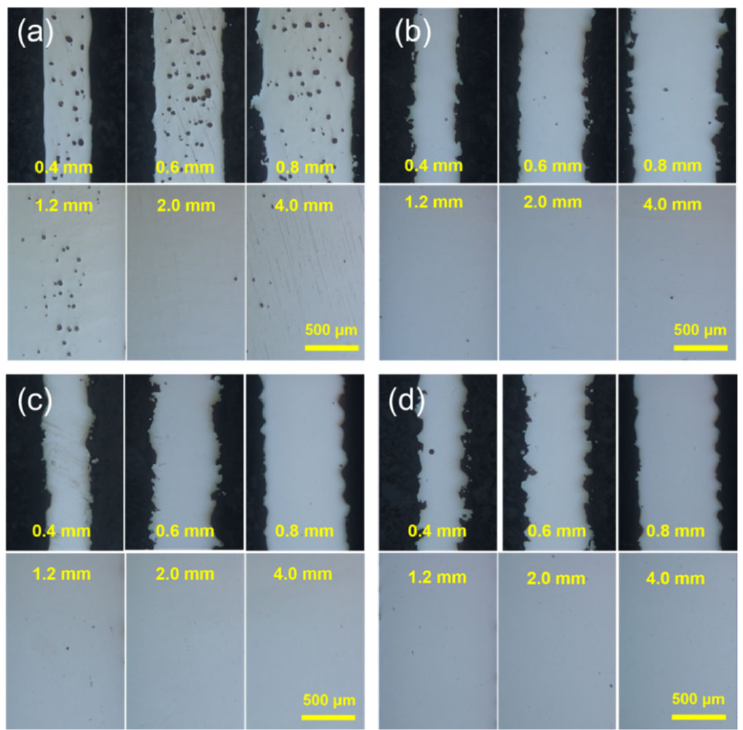
Figure 2. Optical micrographs of SLM-NiTi thin-wall structures fabricated by different laser scanning speeds: ( a ) 400 mm/s, ( b ) 600 mm/s, ( c ) 800 mm/s, and ( d ) 1000 mm/s.